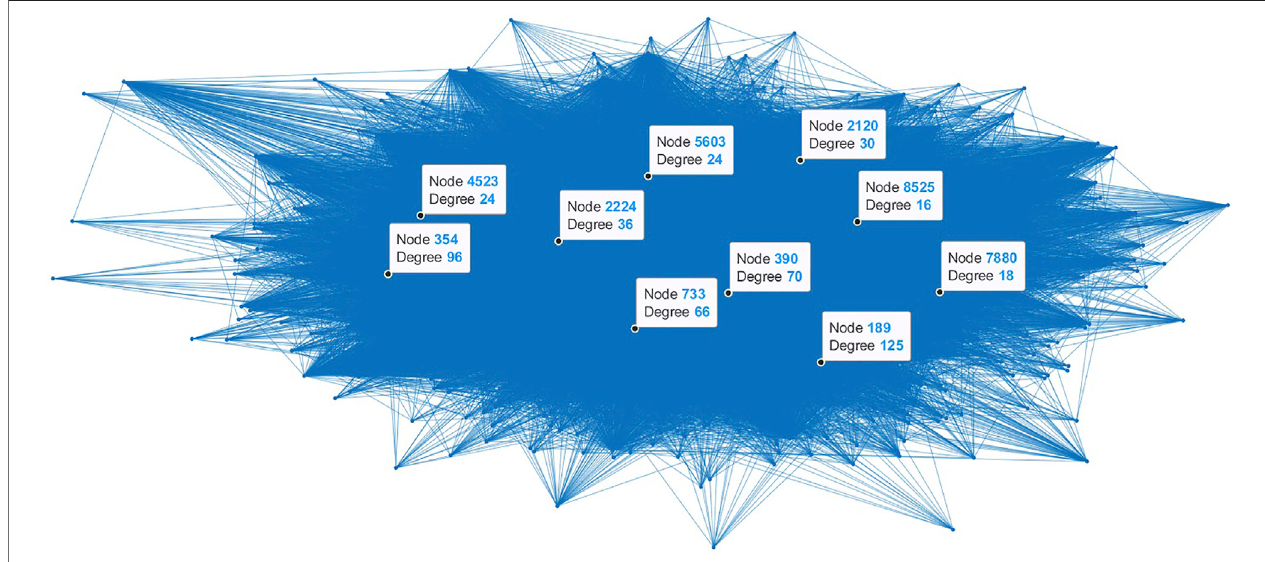
FIGURE 4 | Importance of the average shortest path: in all of the networks above, the colored node is the initiator node that intends to disseminate its information usingagossipprotocol.Theinitiatornodeinthenetwork (A) isabletodisseminatetheinformationinonlyonegossipround.Inthenetwork (B) ,theinitiatornodewillneed two gossip rounds to disseminate the information. In the network (C) more than two gossip rounds are needed.